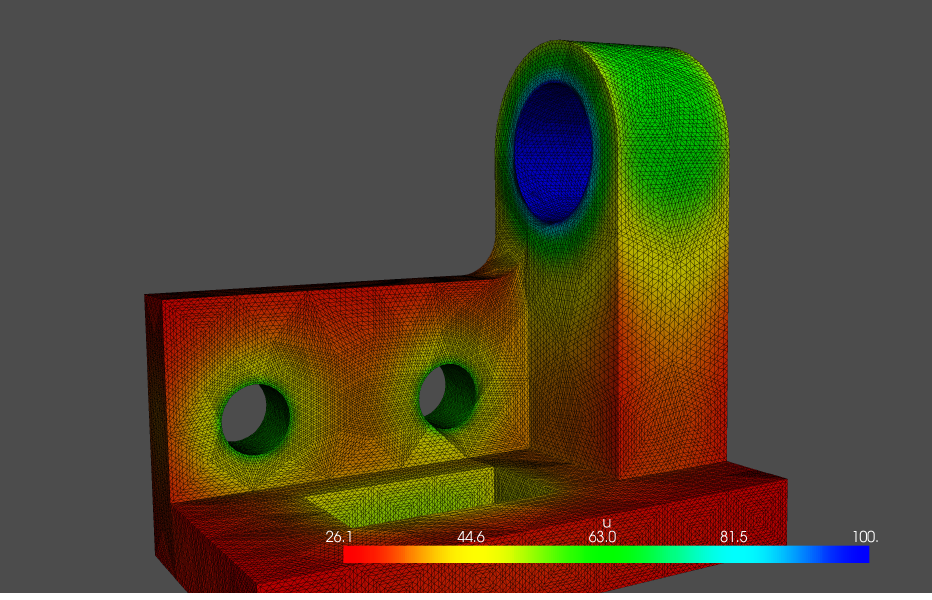
Figure 6. Temperature contour of a function space of order